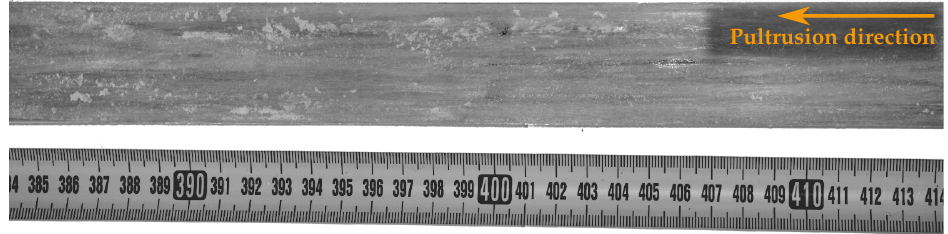
Figure 11. Fully cured material at 400cm showing good dimensional stability.